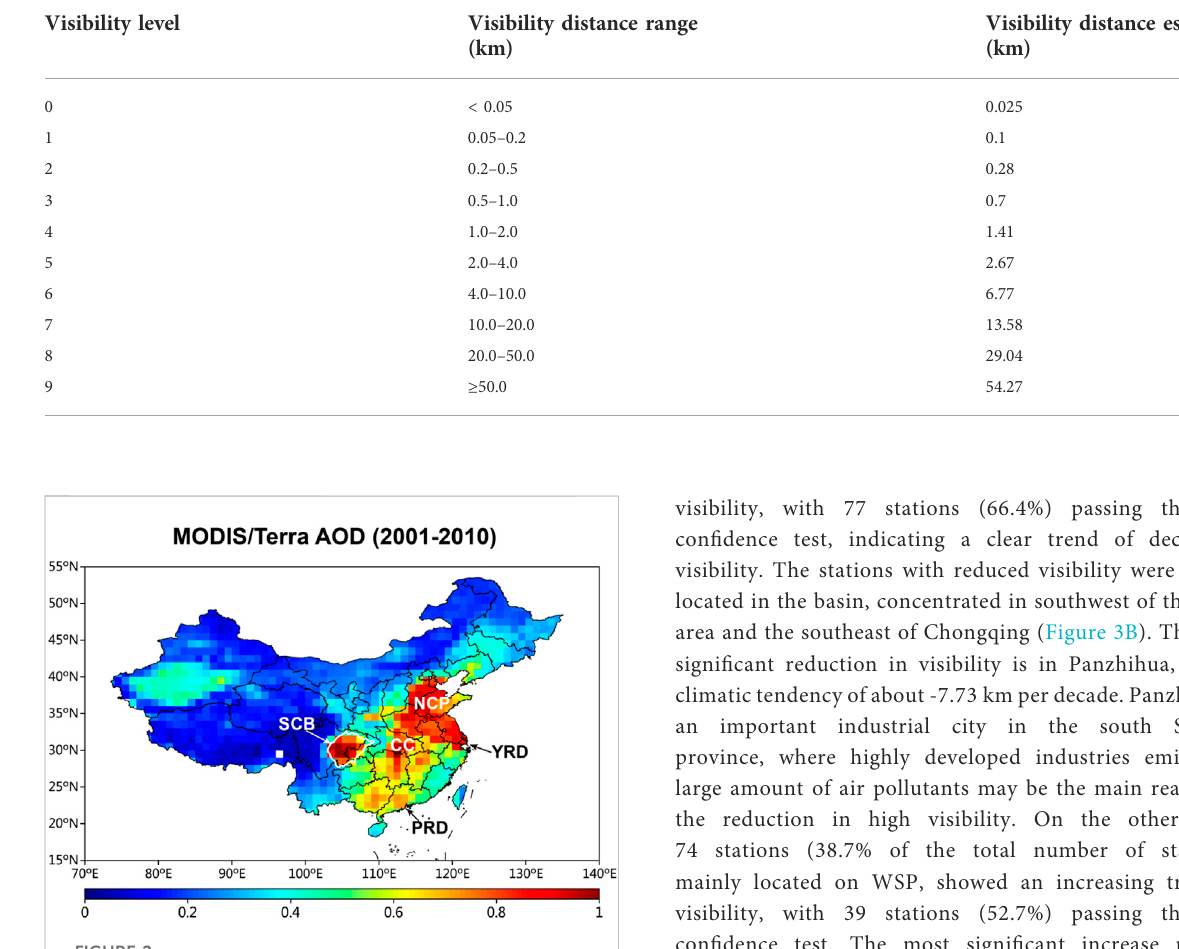
TABLE 1 Visibility ranges and estimations for visibility levels.